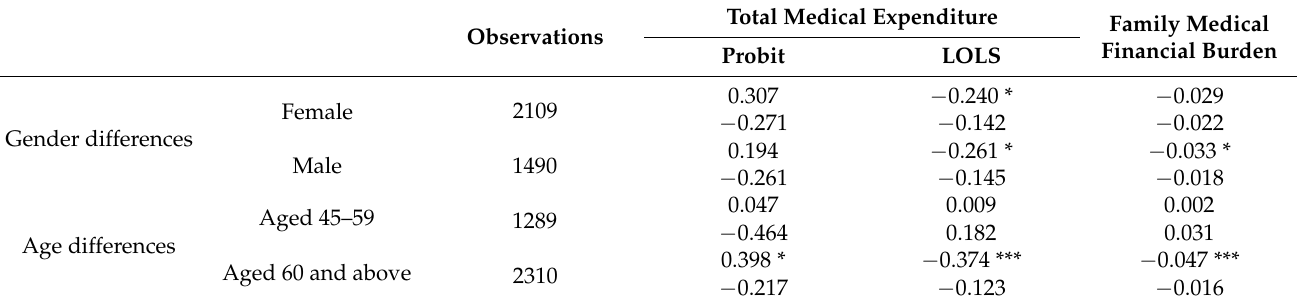
Table 4. Heterogeneity analysis (gender differences and age